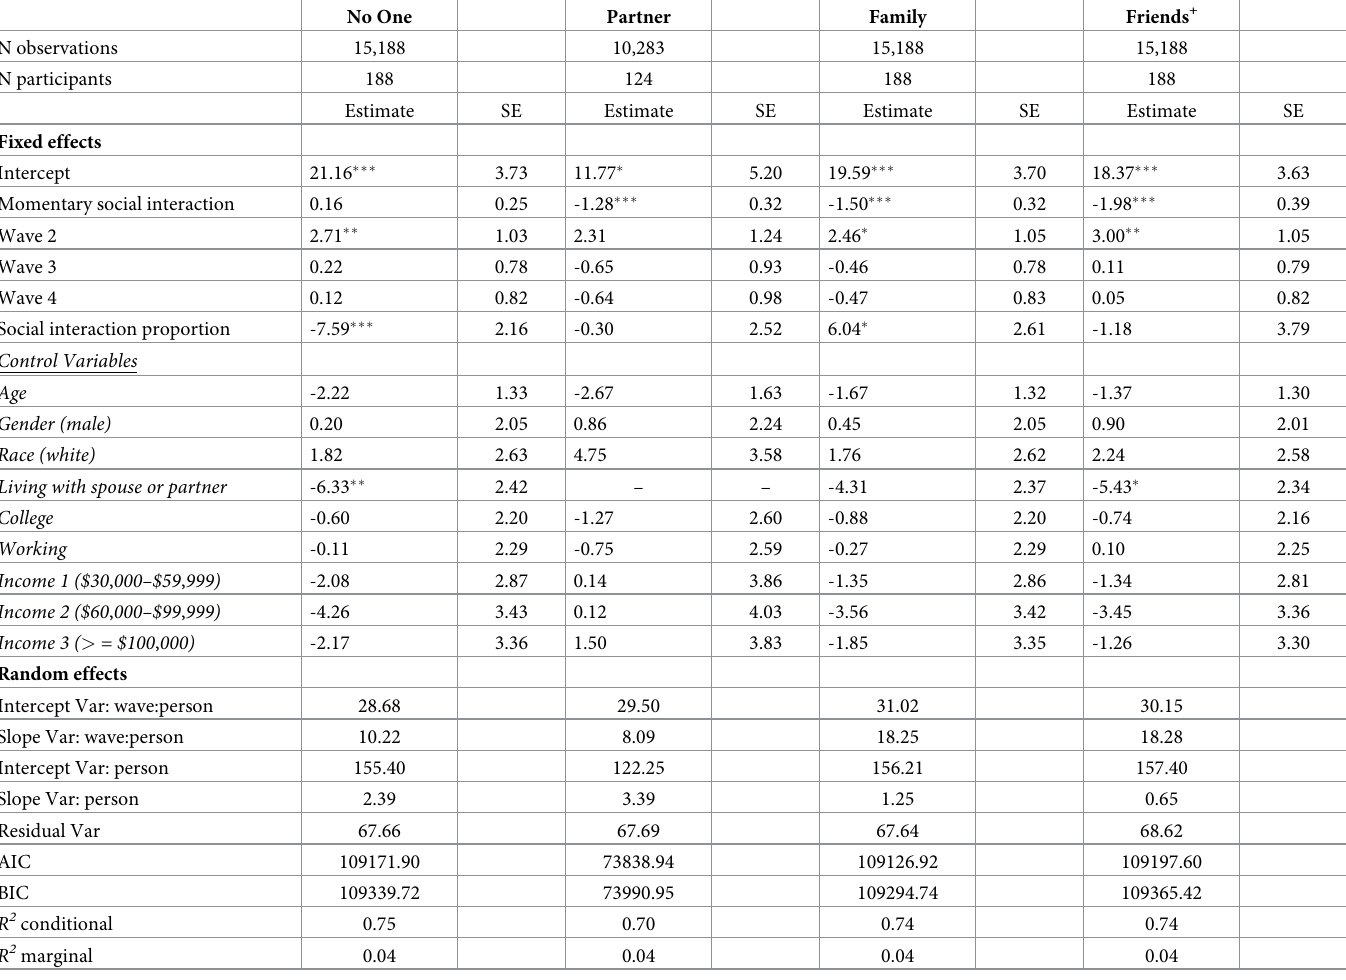
Table 5. Multilevel models with various social interactions and wave predicting